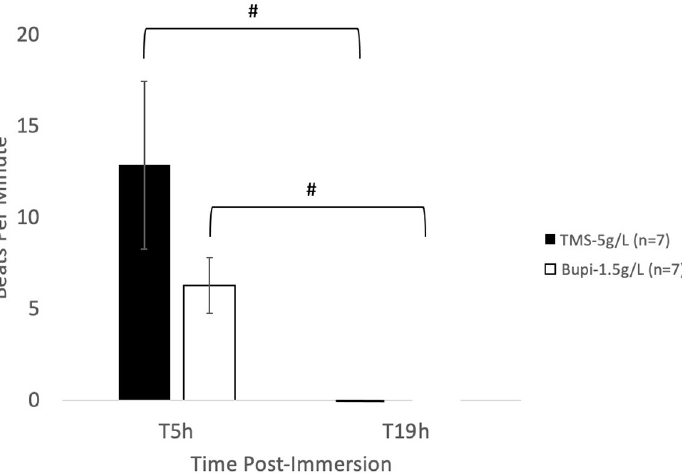
Fig 3. Heart rate after 5- & 19-h immersions. Heart rate (bpm; mean ± SEM) detected audibly via doppler ultrasound evaluation. # values are significantly different ( P < 0.05) between time points.